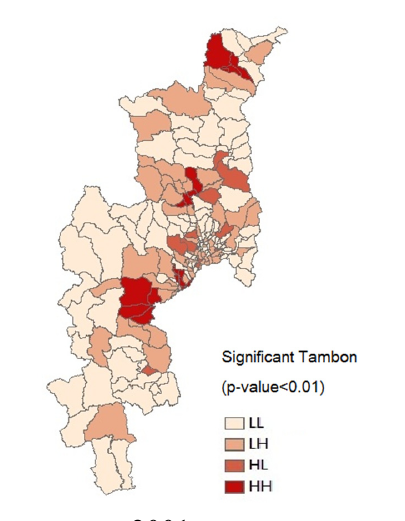
Figure 9. Risk map of influenza potential risk from